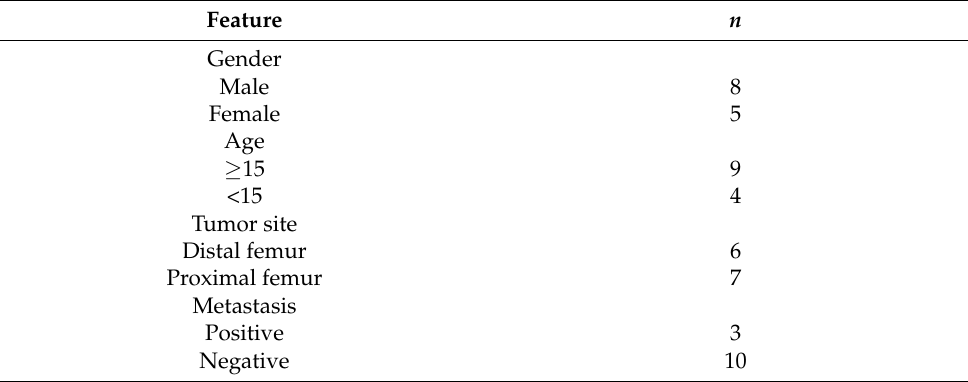
Table 1. The clinicopathological features of 13